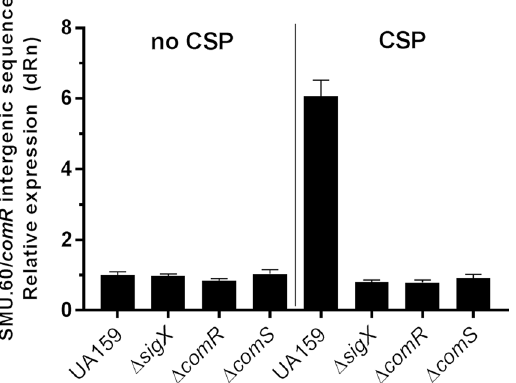
Figure 1. Up-regulation of the intergenic region between SMU.60 and comR is a late competence response. Relative expression of the region located between SMU.60 and comR in the S. mutans wild type UA159 and in the isogenic mutants SM061 ( Δ sigX ), SM066 ( Δ comR ), and SM089 ( Δ comS ). The strains were grown in TSB in the presence or absence of CSP. The real-time PCR data was normalized to the expression values in UA159 with no CSP. The results show mean values and standard errors for 3